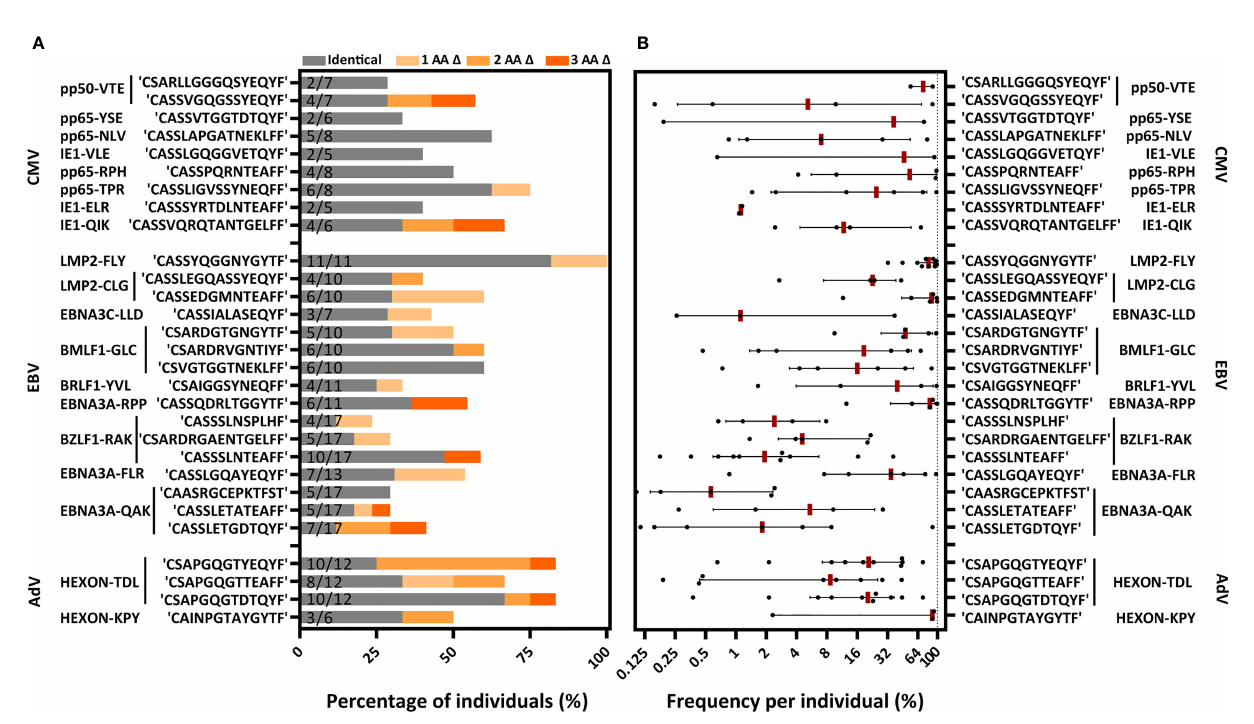
FIGURE 3 | PUB-I and PUB-HS CMV, EBV and AdV-speci fi c CDR3 b AA-sequences are common in different individuals and of high frequencies within the T-cell speci fi cities. (A) Nine-teen different speci fi cities contained PUB-I CDR3 b -sequences, shared by at least 2 individuals. Six speci fi cities contained 2 or 3 different (with different TRBV and/or TRBJ-genes) CDR3 b AA-sequences that were found frequently in different individuals. The total numbers of different T-cell populations (different donors) that contained the PUB-I or PUB-HS CDR3 b AA-sequences are indicated at the inner-side of the y-axis. The occurrence, shown as percentage among healthy individuals, is shown per CDR3 b AA-sequence. PUB-I sequences are shown in grey. Individuals containing PUB-HS sequences with 1, 2 or 3 AA- differences (shown in light-dark orange) compared to the PUB-I sequence were stacked on top of the individuals where the PUB-I sequence was already identi fi ed. (B) Shown is the sum of frequencies of the PUB-I and PUB-HS (1, 2 and 3 AA-differences) CDR3 b AA-sequences per individual. Each dot is one individual, and the red-lines represent the medians with interquartile ranges. AA, amino-acids; nt, nucleotides; D ,